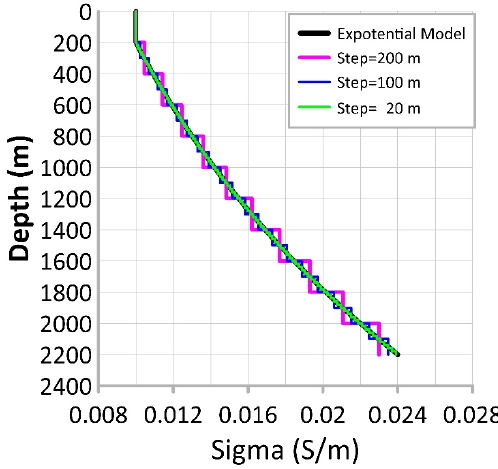
Figure 2. The 1D layered model contains a layer of exponentially varying conductivity (black solid curve) and a stair-step model with steps of 200 m (magenta solid curve), 100 m (blue solid curve) and 20 m (green solid curve). The exponentially varying conductivity model is represented by the “Exponential model” in the legend, and the stair-step model with a step of 200 m is marked as “Step = 200 m” (and similarly for the other stair-step models). Please note that the bottom layer (the anisotropic layer) is not shown in the figure.